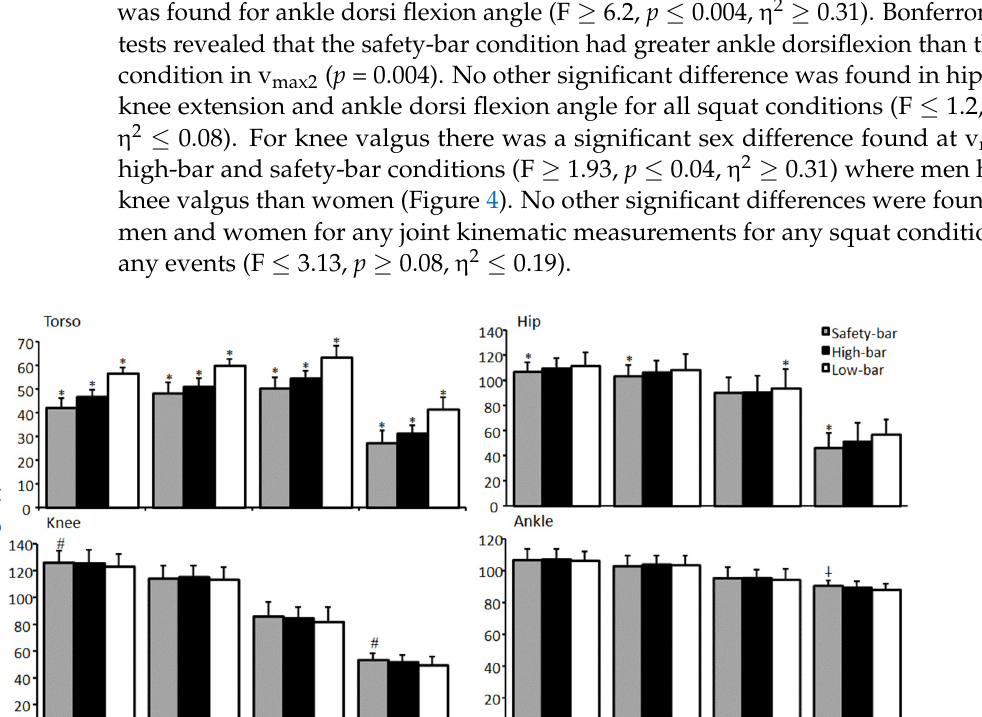
Figure 2. Mean ± standard deviation (SD) ( A ) displacement and ( B ) velocity at the events v max1 , v min , and v max2 , and their timings for the high-bar, low-bar, and safety-bar squat during 3-RM.